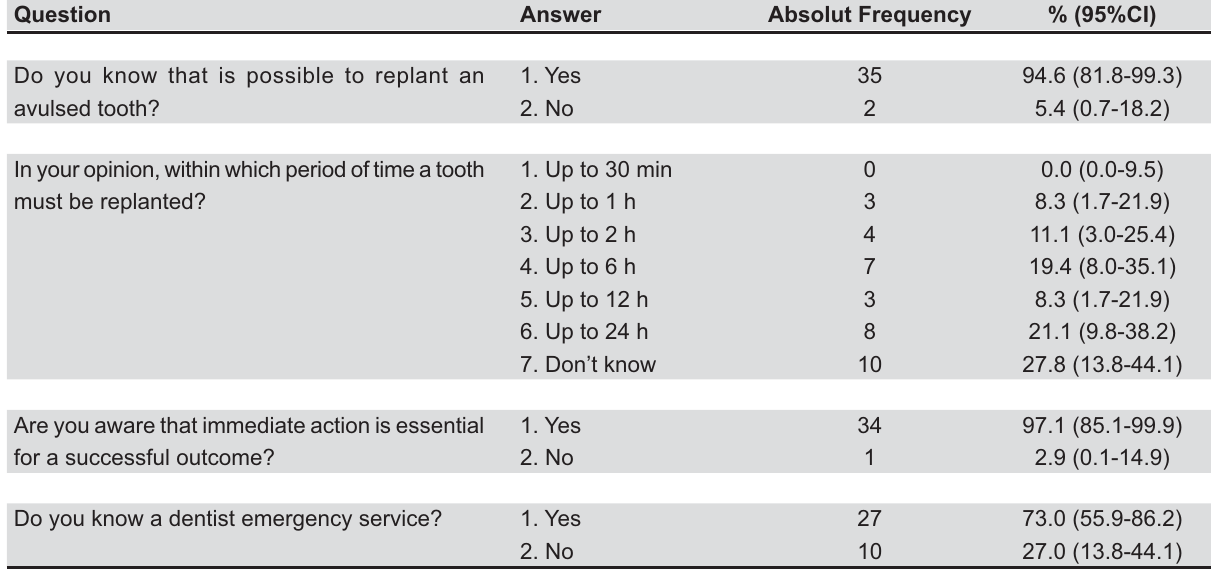
Table 2- Knowledge of heads of club’s health departments about the conducts to be adopted in case of dental injuries during the game ?(cid:26)(cid:19)(cid:7)(cid:11)(cid:10)(cid:6)(cid:21)